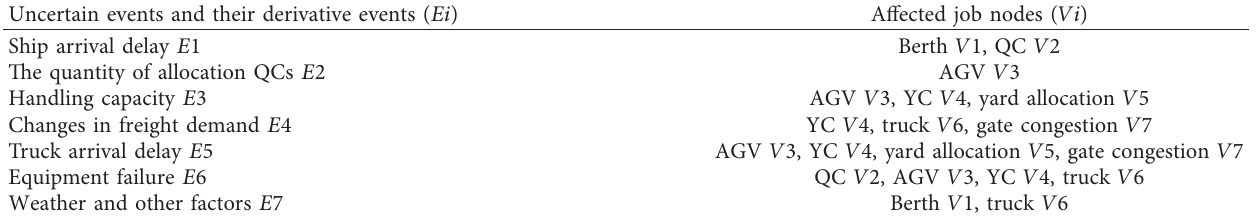
Table 1: List of uncertainty events and job nodes.